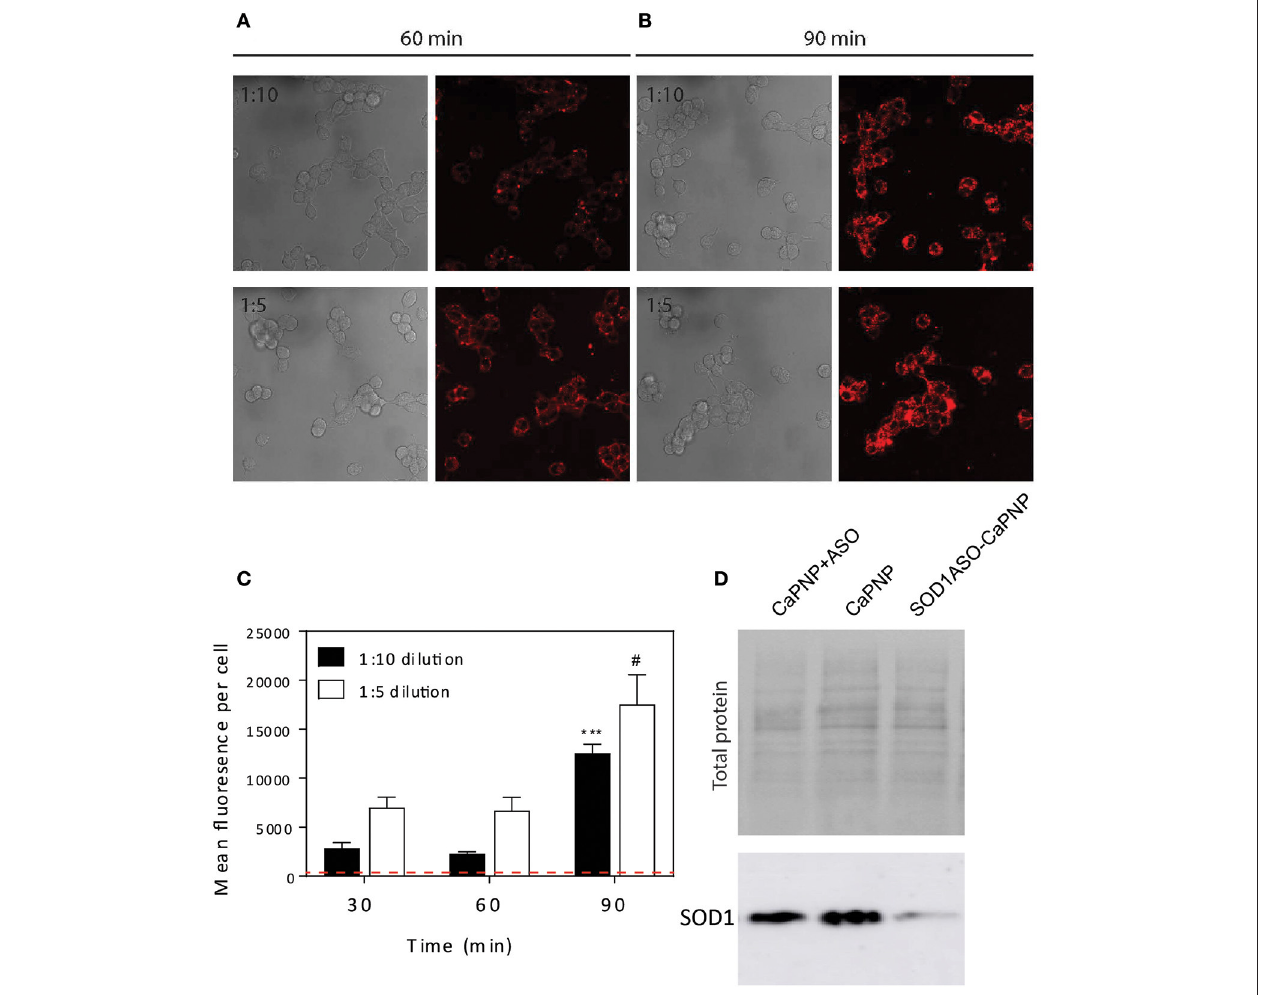
FIGURE 2 | Internalization of CaP-lipid NPs into NSC-34 cells and knockdown of SOD1 protein expression in HEK293 cells. The CaP nanoparticles contained LissRdB-DSPE (Ex = 560 nm; Em = 583 nm) in the outer lipid layer. NSC-34 cells were incubated at 37 ◦ C with LissRdB-DSPE CaP-lipid NPs diluted either 1:5 or 1:10 (v/v) for 30, 60 (A) and 90 min (B) . Images were acquired with a 63 × objective (512 × 512 pixels; physical length 246.03 µ m × 246.03 µ m). Change in average cell fluorescence over 90 min incubation period (C) . Red dotted line represents auto fluorescence of NSC-34 cells for comparison. *** P < 0.001 and # P < 0.05 signifies significant difference compared to respective 30 min data. HEK293 cells were treated with SOD1-ASO CaP-lipid NPs for 72 h at 37 ◦ C (Lane 3). Control treatments included non-loaded CaP-lipid NPs (Lane 2) and non-loaded CaP-lipid NPs with SOD1-ASO free in solution (Lane 1). Controls using Lipofectamine 2000 Transfection Reagent with SOD1-ASO or scrambled negative SOD1 oligonucleotide are not shown here. The change in SOD1 protein expression (16 kDa) was visualized sing SuperSignal West Pico Chemiluminescent Substrate and exposed using an Amersham 600RGB Imager (D)